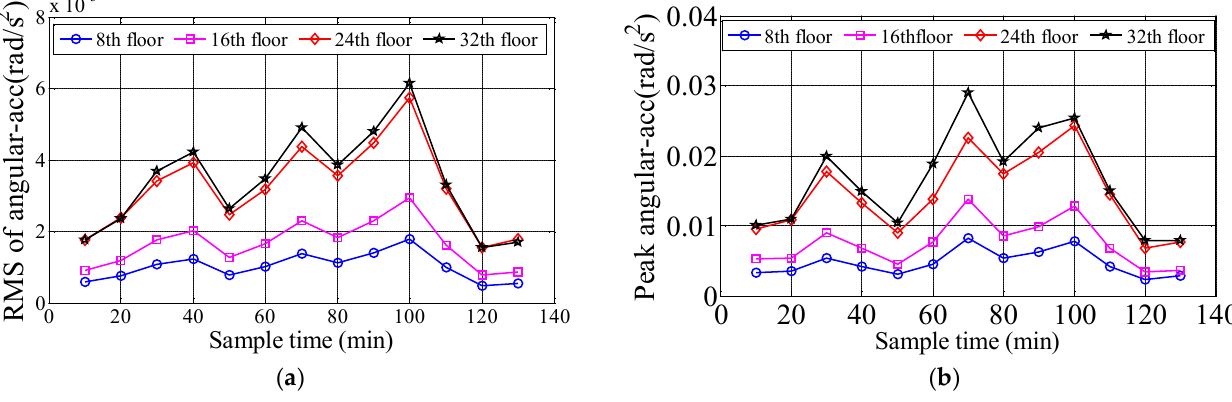
Figure 9. The 10-min variation of RMS of angular-Acc and peak angular accelerations on different floors. ( a ) RMS of angular-Acc; ( b ) Peak angular accelerations.